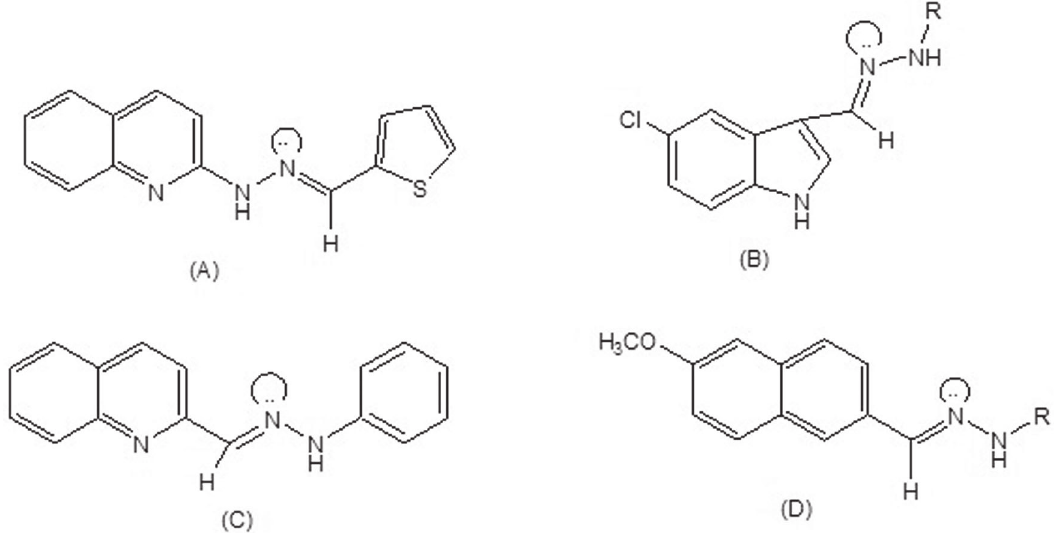
FIGURE 4 - Z , E -isomerism of some hydrazono-compounds